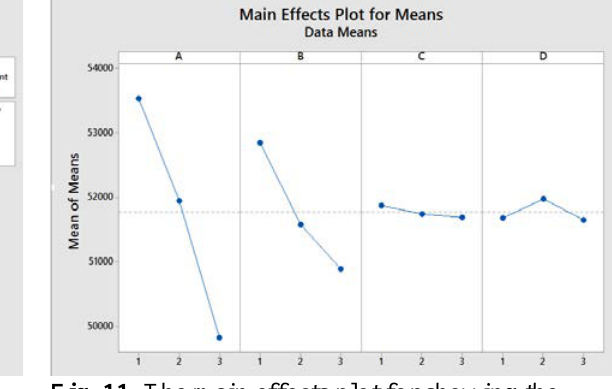
Fig. 10. The normal plot of the effects between input parameters for the proposed hybrid method